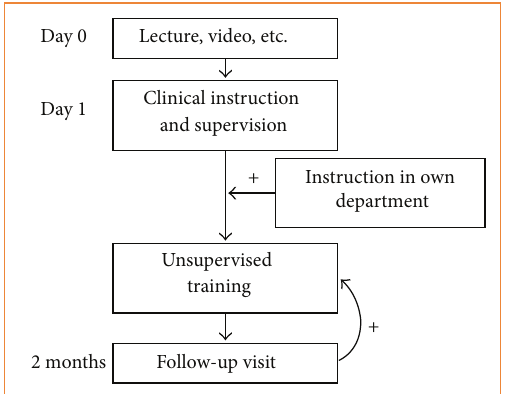
Figure 2: The proposed training program with follow-up. The transition from supervised training to unsupervised training might be facilitated when instruction is done at the trainees department. A scheduled follow-up visit might also have a positive feedback on the initiation and continuing of the unsupervised